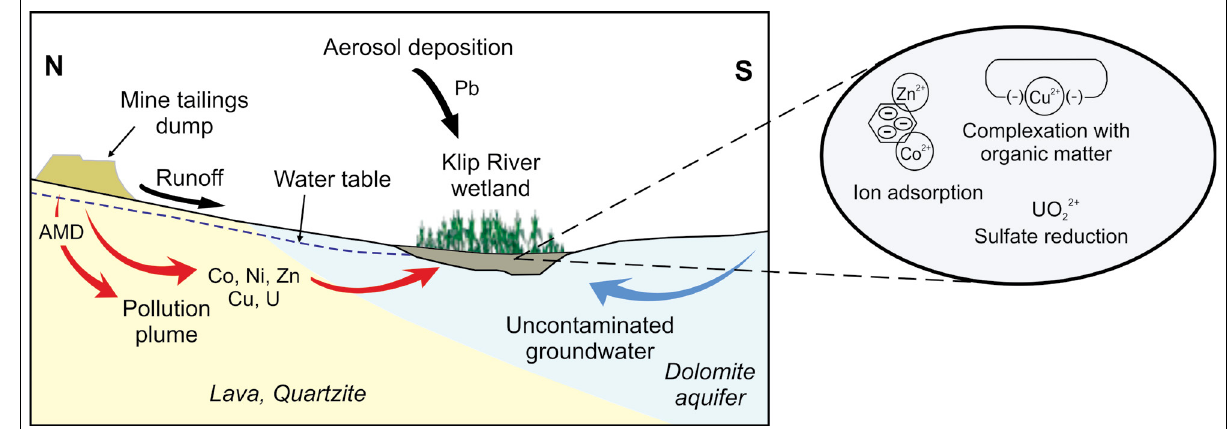
Figure 9: Conceptual hydrogeological model showing the main transport pathways of metal contaminants to the Klip River wetland (diagram not to